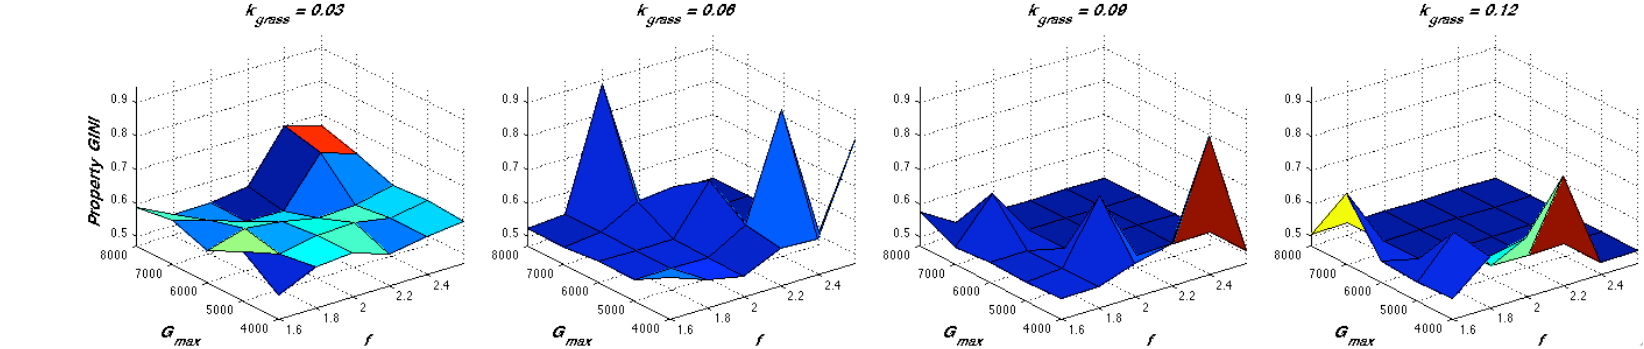
Figure A2.5: Property GINI across dimensions of grass capacity G (/t). Individual surfaces show GINI as a function of grass capacity and stocking factor f at a constant intrinsic grass growth